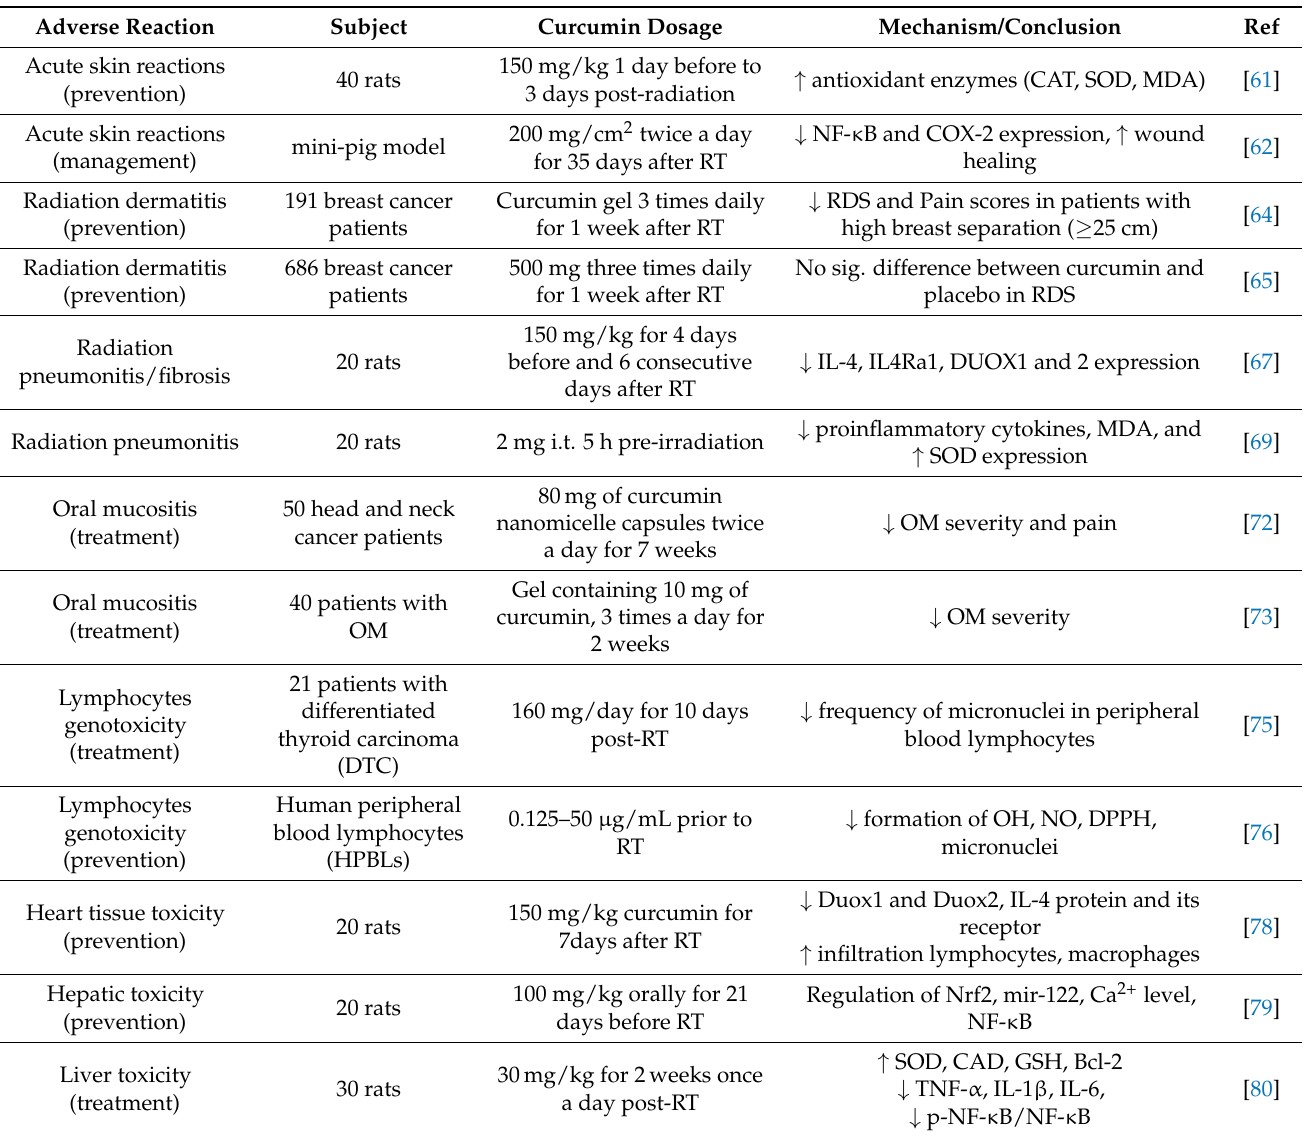
Table 2. Recent studies on radiotherapy adverse reactions prevention/management with curcumin. ↑ , upregulation; ↓ ,